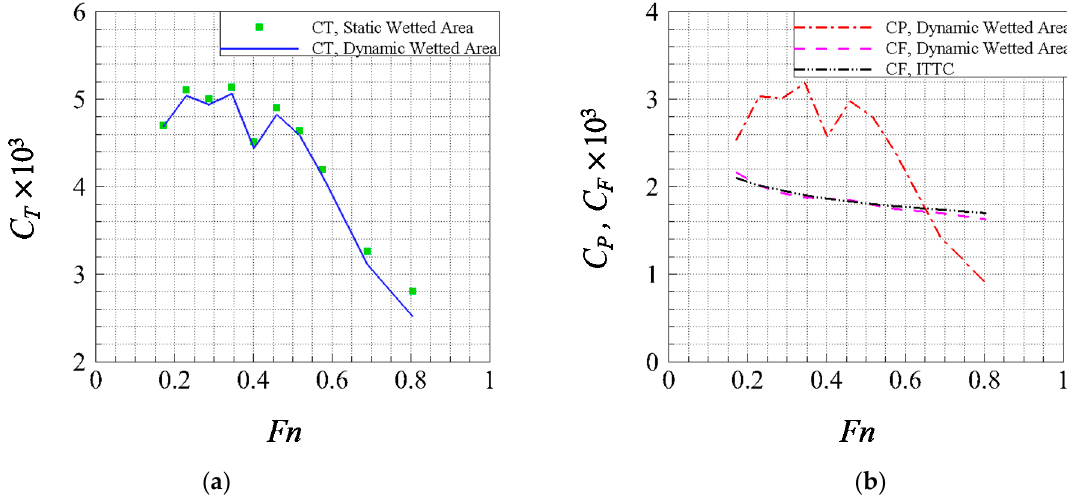
Figure 10. Total resistance coefficient ( a ), and pressure and frictional resistance coefficients ( b ) of the London Demonstrator in deep water.